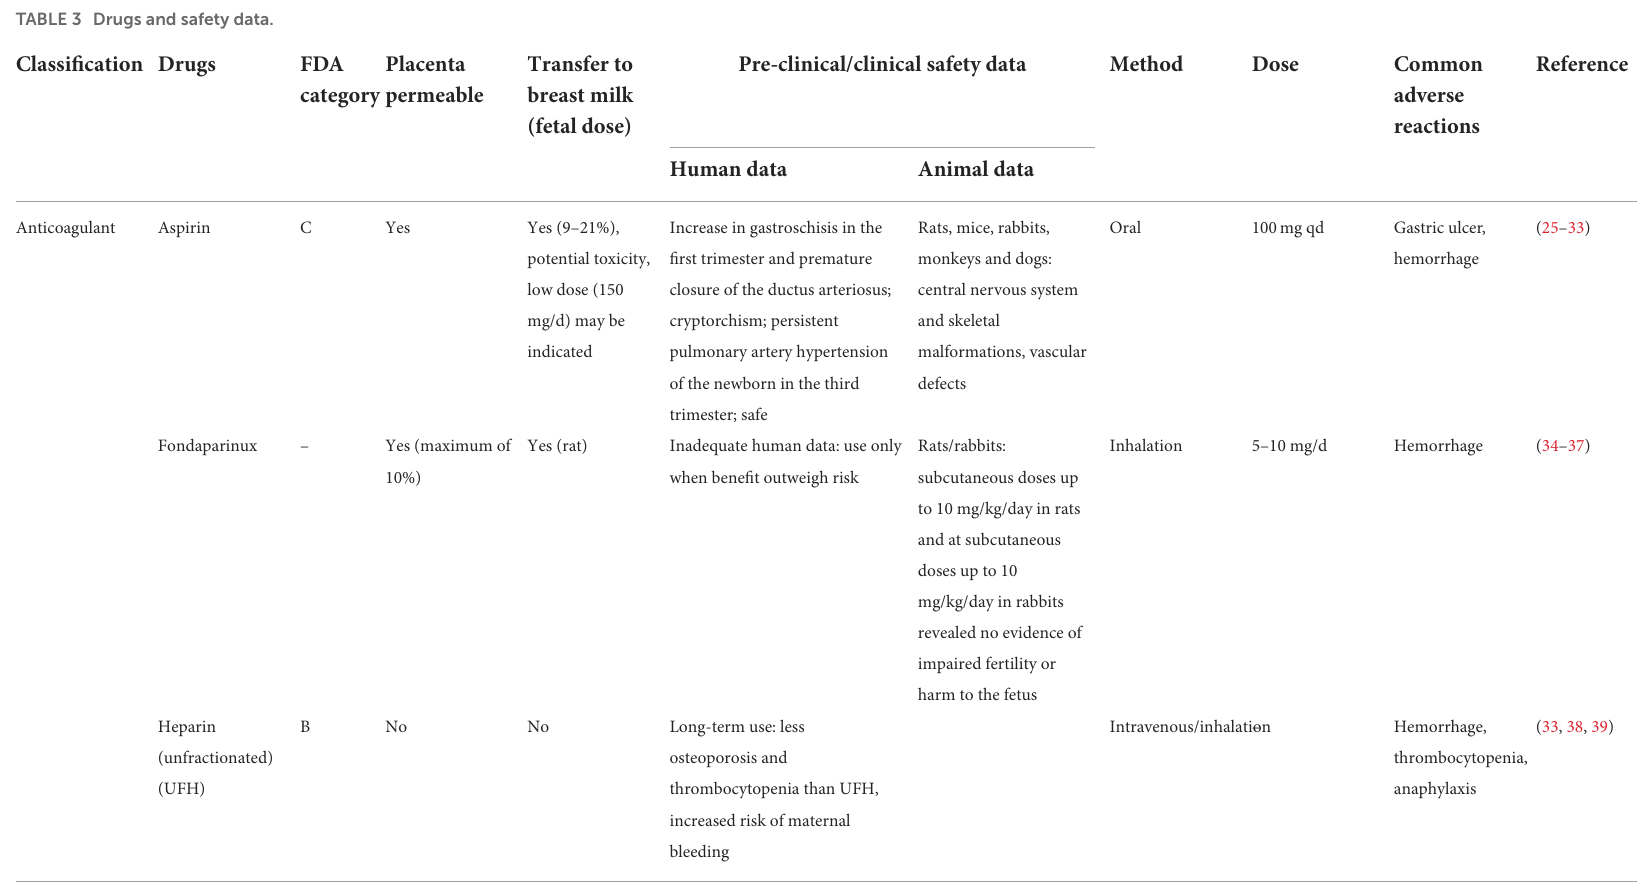
TABLE 3 Drugs and safety